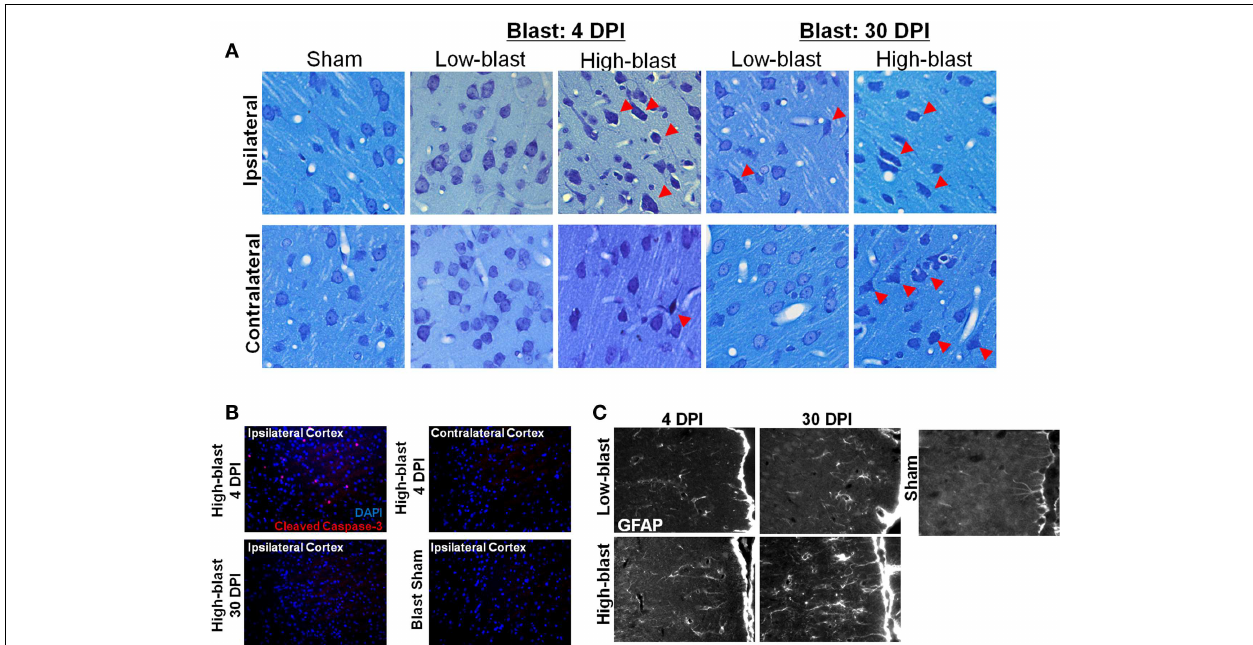
observed in the ipsilateral cortex at 4days post-blast, but not in the contralateral cortex, and the stain was no longer present at 30days post-blast. No staining was present in the sham brain. In the medial prefrontal cortex, a region with significant FA changes, astrocytes stained with GFAP exhibited extensive hypertrophy in the high-blast brain at 30days compared to the sham brain, but astrogliosis was noticeably less at 4days post-blast or in the low-blast